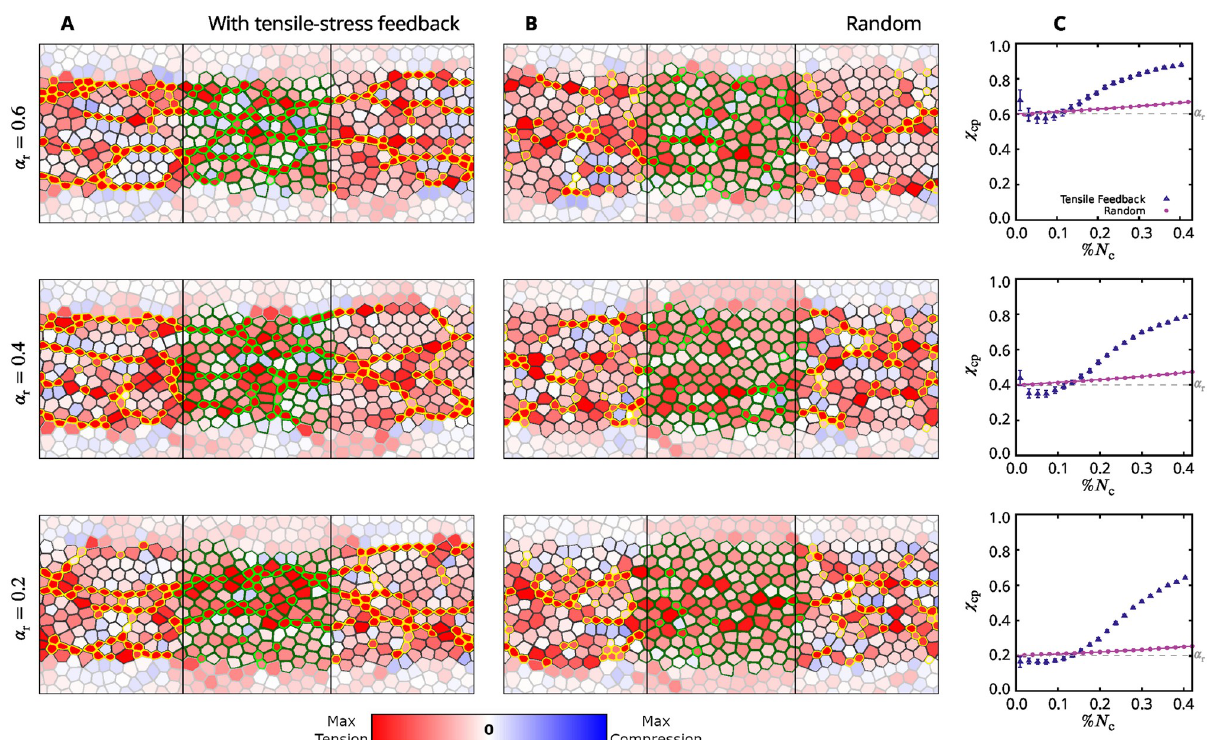
Fig 10. The effect of tensile feedback on constrictions in a disrupted zone with decreased constriction probability. ( A,B ) Simulation snapshots for the AGF model with a band of cells whose constriction probability is decreased by the factor α r = 0.6 (top) 0.4 (middle) and 0.2 (bottom) relative to the probability outside the affected zone. The results are shown for the system with tensile feedback (A) and the stress insensitive random system (B). The affected active cells with reduced constriction probability are outlined in green; otherwise the images follow the color convention used in Fig 8. Frames correspond to % N c = 0.37. The extent of the disrupted zone is indicated by two vertical black lines. ( C ) Plots showing the constriction perturbation coefficient χ cp , Eq 15, vs the fraction of constricted cells % N c for a given value of α r . Simulation results (symbols); exact theoretical result, Eq 18, for uncorrelated random constrictions (solid lines). The thin dashed lines represent the values of α r . The coefficient χ cp reflects how well the affected region is performing compared to the unaffected areas, with χ cp = 1 indicating full recovery of the affected region. All three plots show that the system with tensile feedback exhibits substantial constriction recovery at sufficiently large values of % N c . Tensile-sensitive simulations ( n = 120); random simulations ( n = 16000). Error bars: